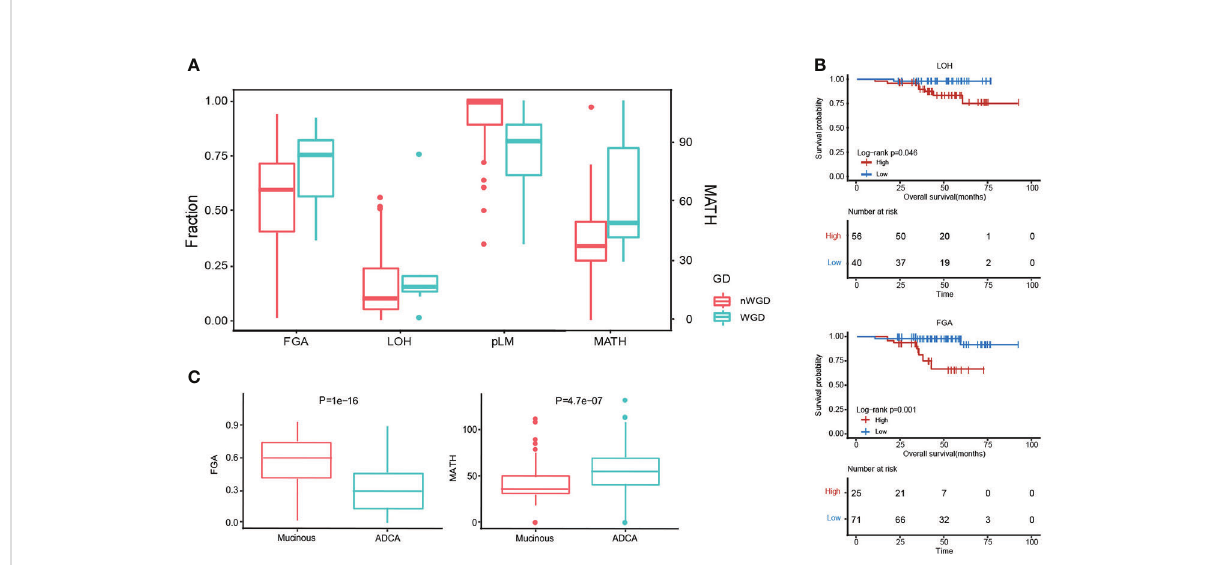
FIGURE 3 Genome instability comparison between MPA and LUAD. (A) , Evaluation of fi ve genomic instability indexes in MPA. (B) , Survival analysis combing genomic instability indicators. (C) , Comparison of FGA and MATH between MPA and